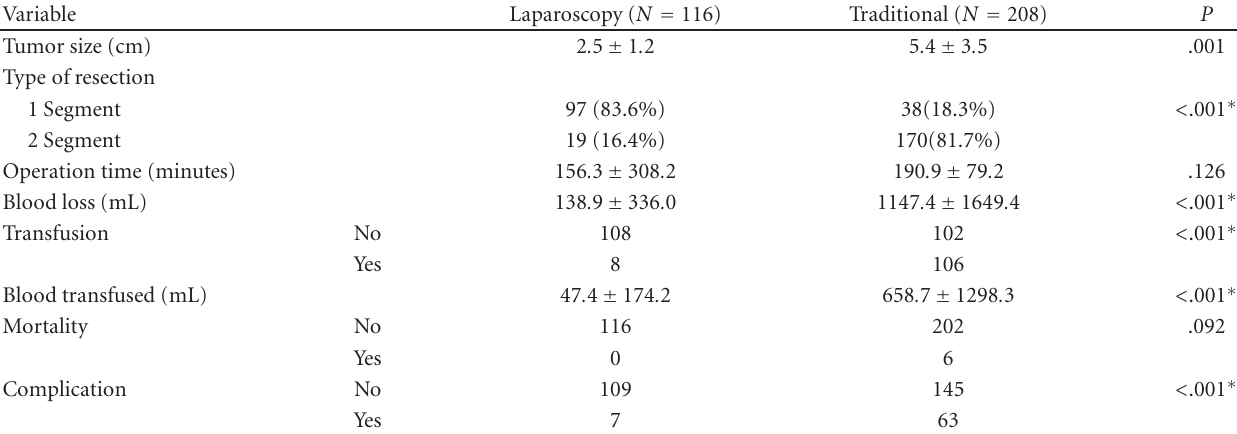
Table 2: Comparative data of laparoscopy and traditional